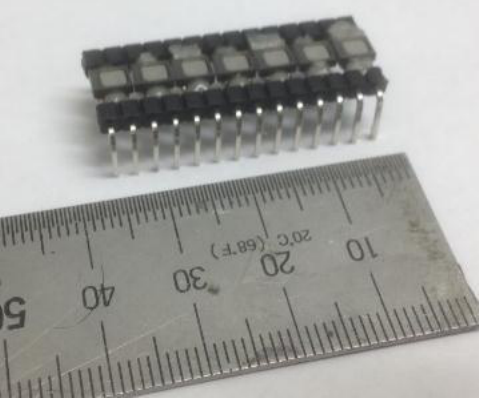
Figure 3. Detail of 7-element MEMS sensor array with 2-mm spacing: each MEMS unit was soldered and then coated with